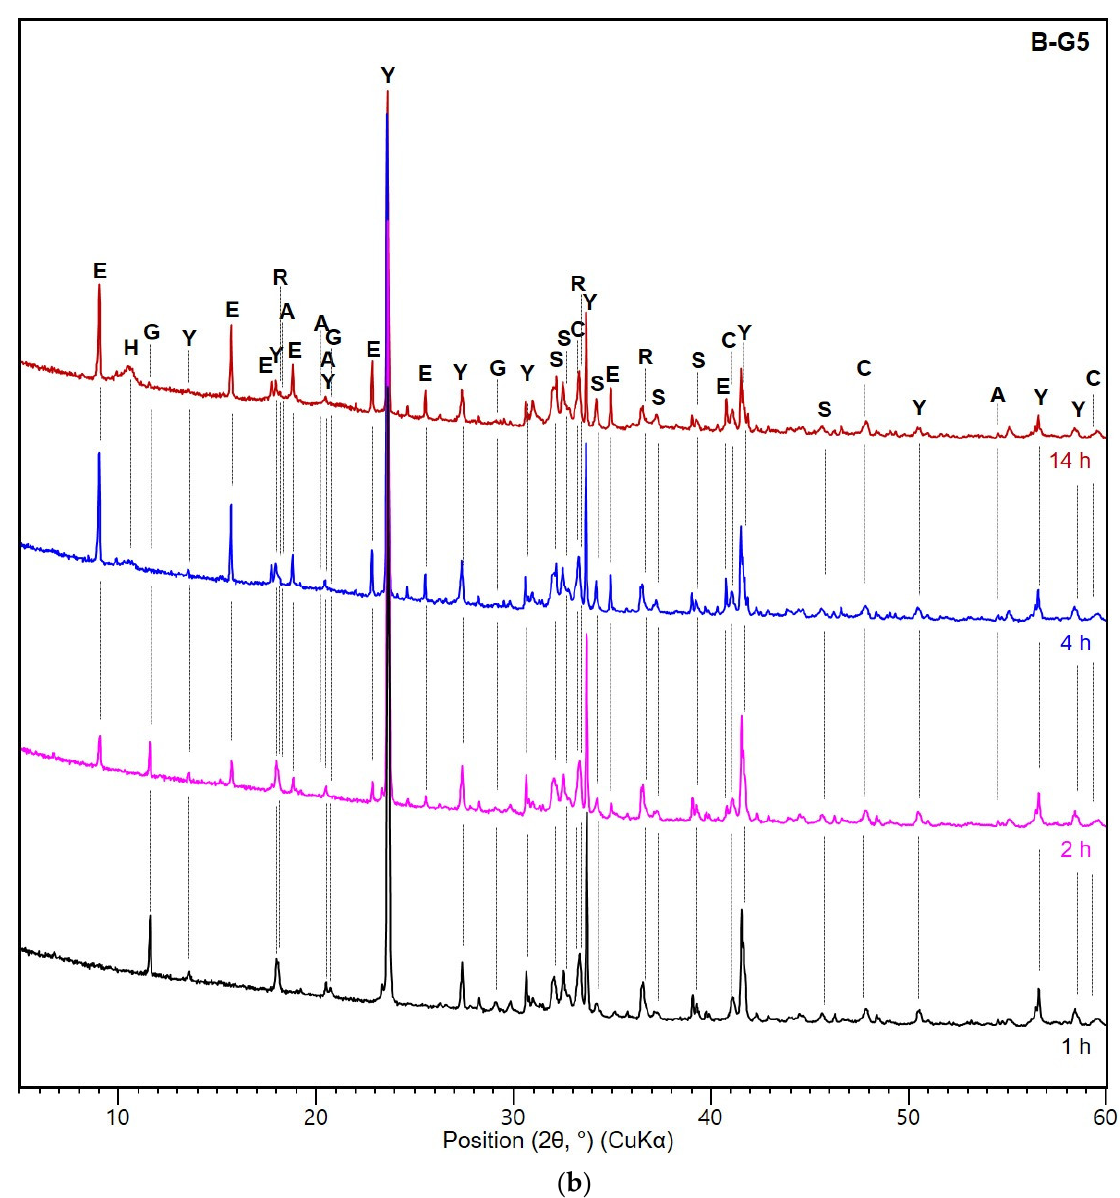
Figure 8. XRD patterns of ( a ) B-G0 and ( b ) B-G5 at each curing time. O: CAH 10 ; E: ettringite; M: monosulfate; H: hydroxy-AFm; Y: ye’elimite; R: mayenite; A: AH 3 ; S: C 2 S; C: C 3 A; G: gypsum.